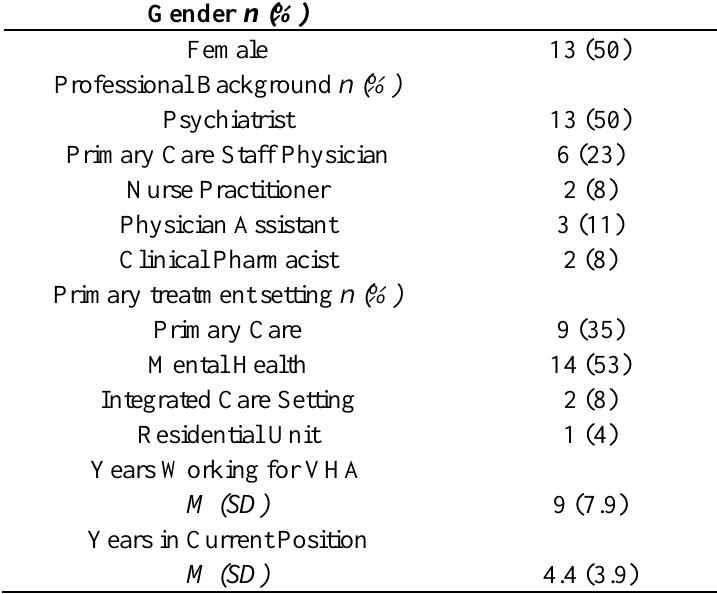
Table 1. Prescribing Clinicians’ Characteristics.Gender, professional background, treatment setting, and years in practice of the 26 prescribing clinicians in our